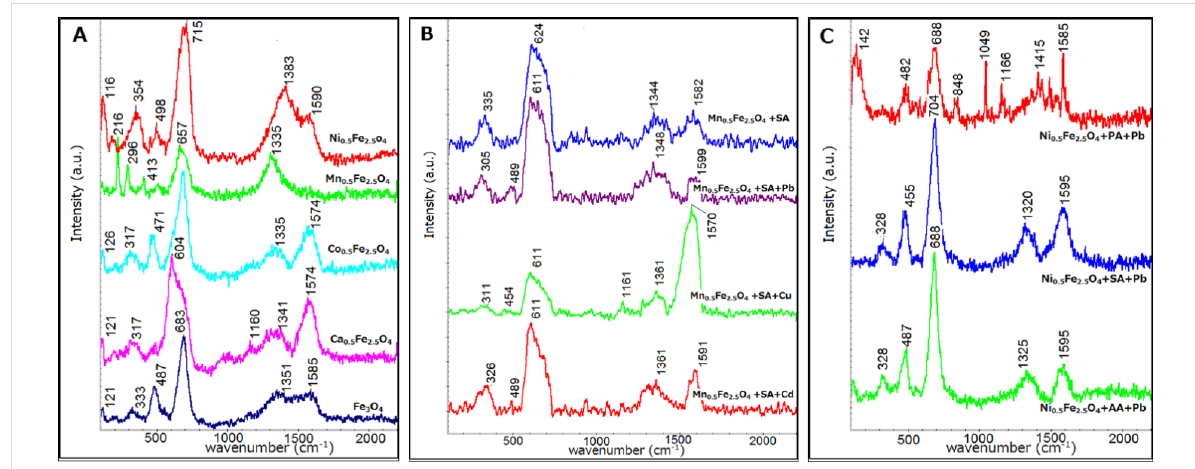
Figure 5: Raman spectra of A) ferrite nanoparticles; B) SA-modified nanoparticles with attached heavy-metal ions; C) various anhydride-modified nanoparticles with attached Pb ions.